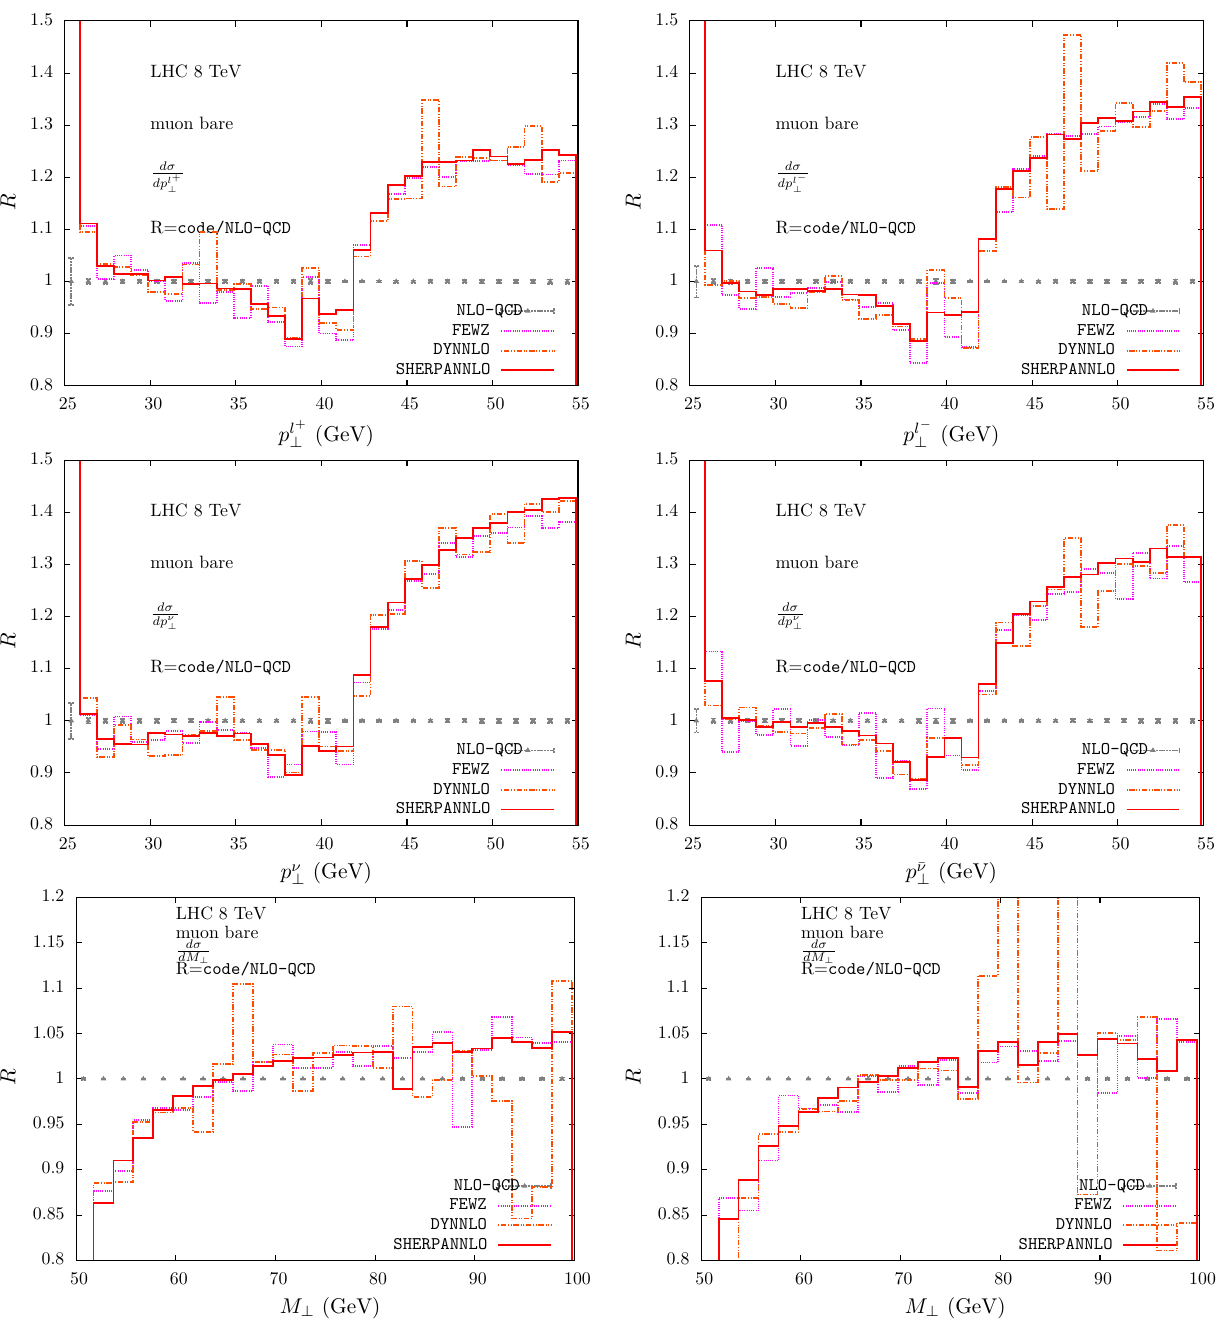
Fig. 17 NNLO QCD effects, expressed in units of NLO QCD, in pp → μ ± ν μ + X in the benchmark setup with ATLAS/CMS cuts at the 8 TeV LHC, for μ + ν μ ( left plots ) and μ − ¯ ν μ ( right plots ) final states. Comparison of the lepton transverse momentum ( upper plots ), neutrino